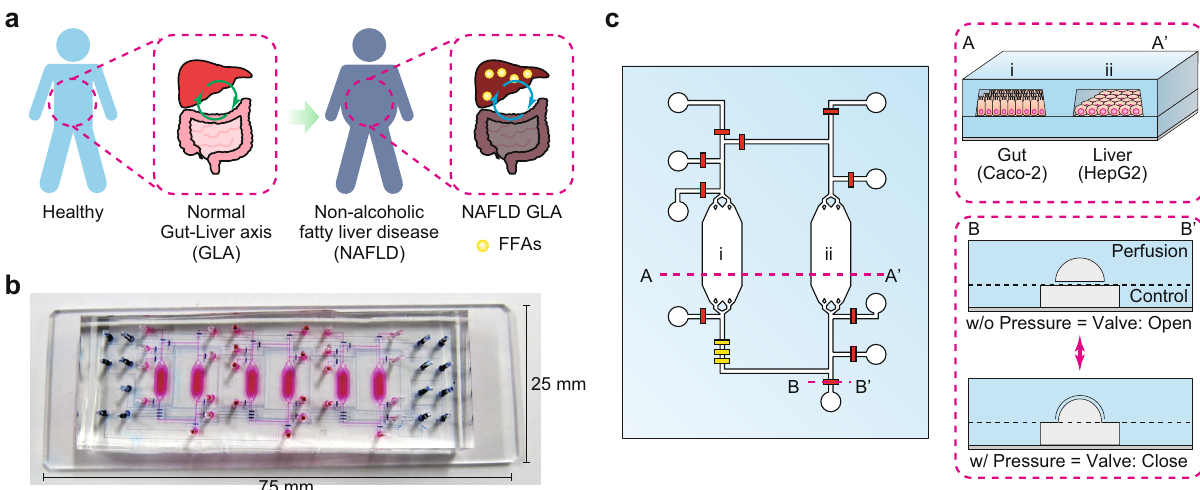
Fig. 1 Design of the iGLC platform to recapitulate NAFLD. a Schematic for NAFLD progression by FFAs via the GLA. b Photograph of an iGLC platform. The perfusion and control layers are colored in pink and blue, respectively. c Illustration of the iGLC platform used for NAFLD. Two cell culture chambers are used for gut cells (Caco-2) and hepatocytes (HepG2) and are linked via a micro fl uidic channel with a micropump to achieve closed medium circulation of FFAs. Within the microvalves, each cell culture chamber is individually accessible without the risk of cross-contamination. Thus, this setup allows the inter-tissue interaction to be evaluated. A – A ’ shows the cross-section of the cell culture chambers for the Caco-2 gut and HepG2 liver cells. B – B ’ shows the cross-sectional view of the open and closed integrated microvalves. Because of the elastic PDMS membrane, the normally open valve is closed by applying higher pressure to the micro fl uidic channel in the control